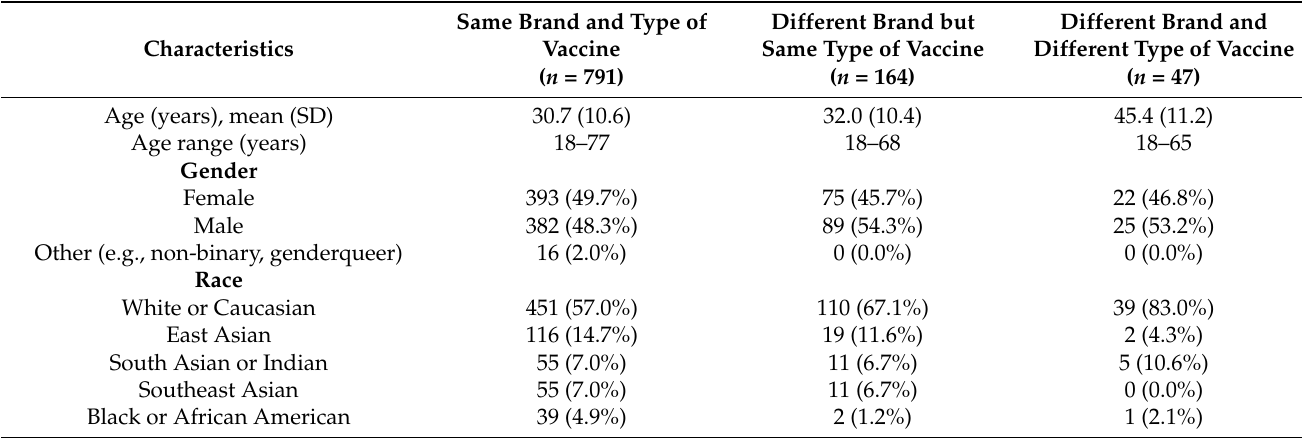
Table 1. Demographic characteristics of participants ( N =